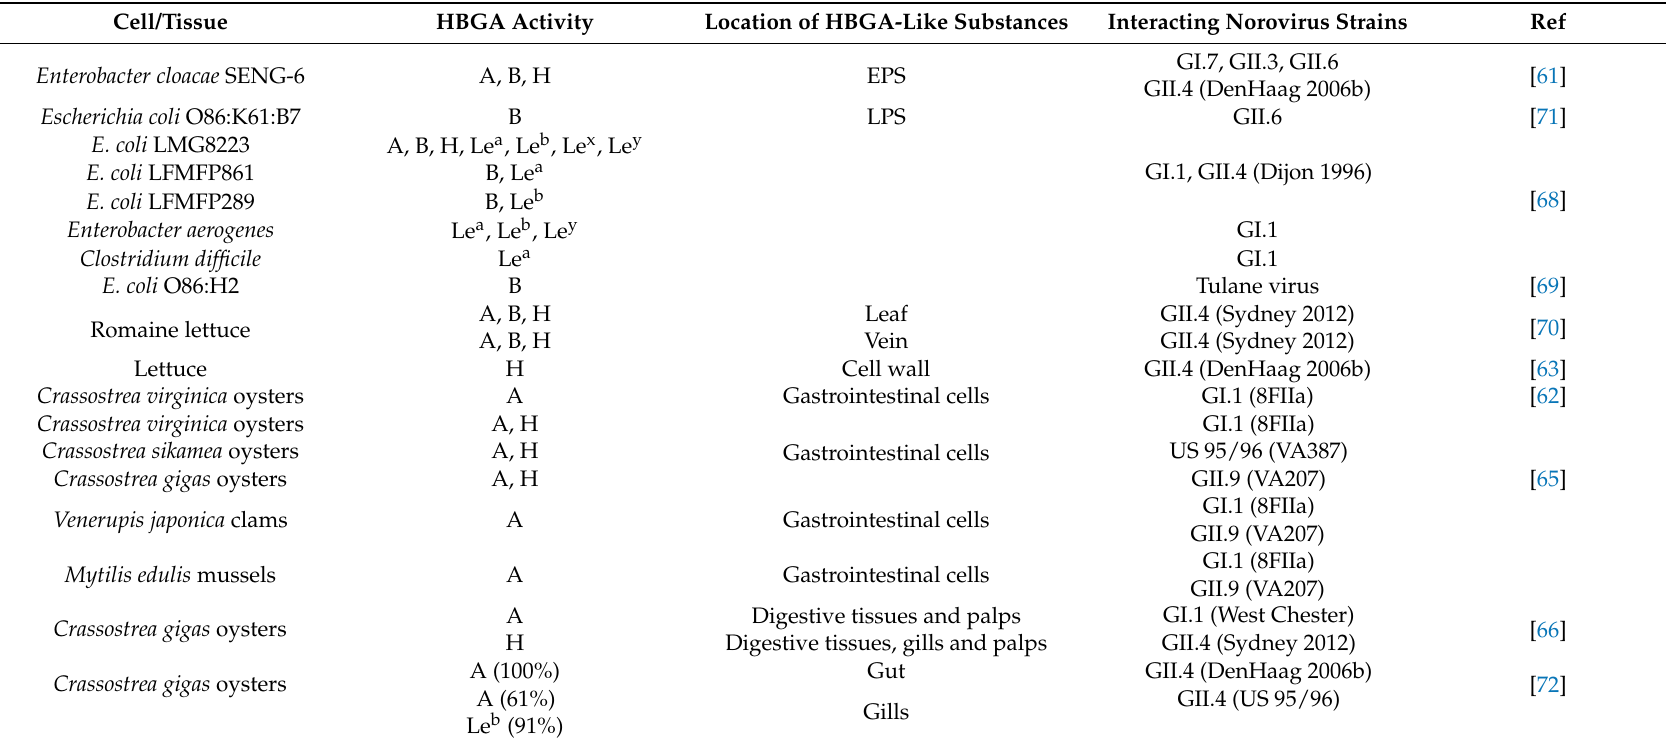
Table 1. Specific interactions between human norovirus and histo-blood group antigens (HBGA)-like substances present in environmental matrices. EPS, extracellular polymeric substances; LPS,